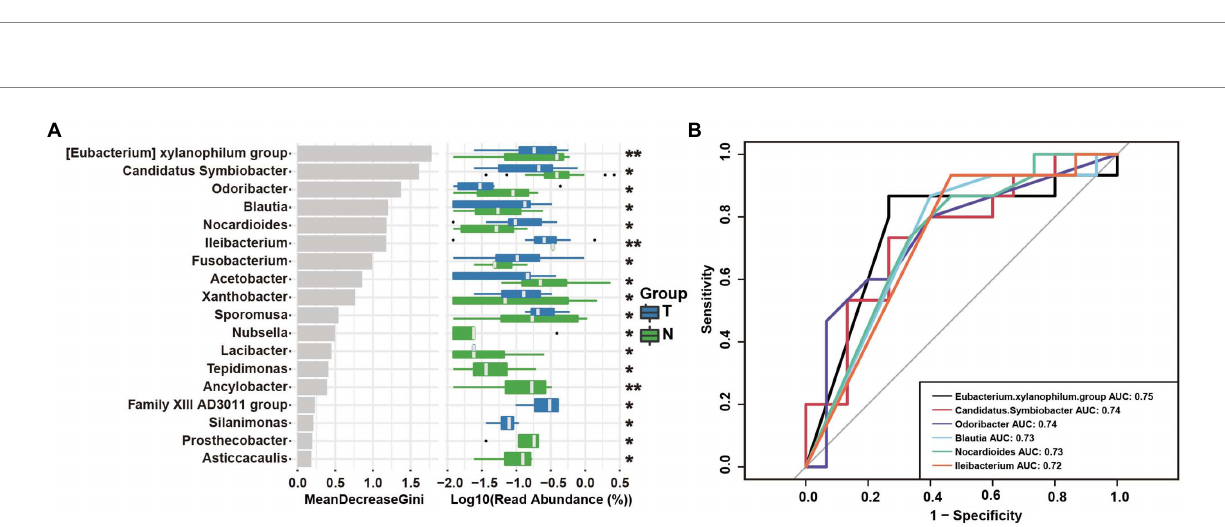
FIGURE 7 Operational taxonomic unit (OTU)-based markers in the uterus of the embryo-arrest and normal pregnancy groups. (A) Random forest algorithm of the uterine microbiota in the two groups. (B) Receiver operating characteristics (ROC) curve for the prediction of embryo-arrest. T, embryo-arrest group; N, normal pregnancy